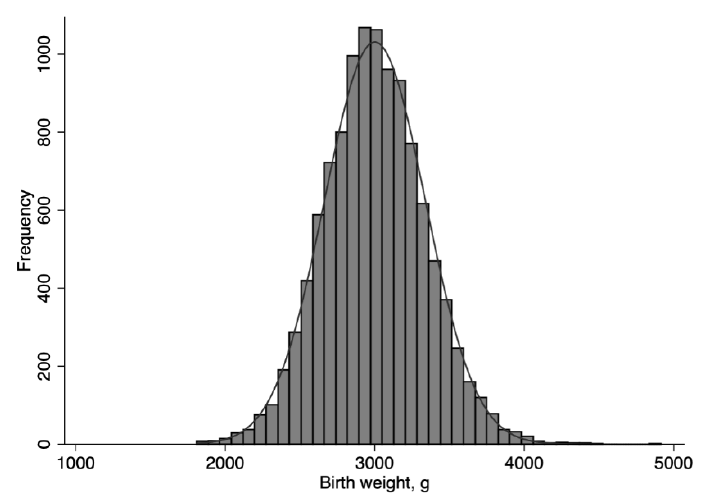
Figure 1. Distribution of birth weight among 11,224 neonates who received standardized thermal control and nutrition regulation to meet basal